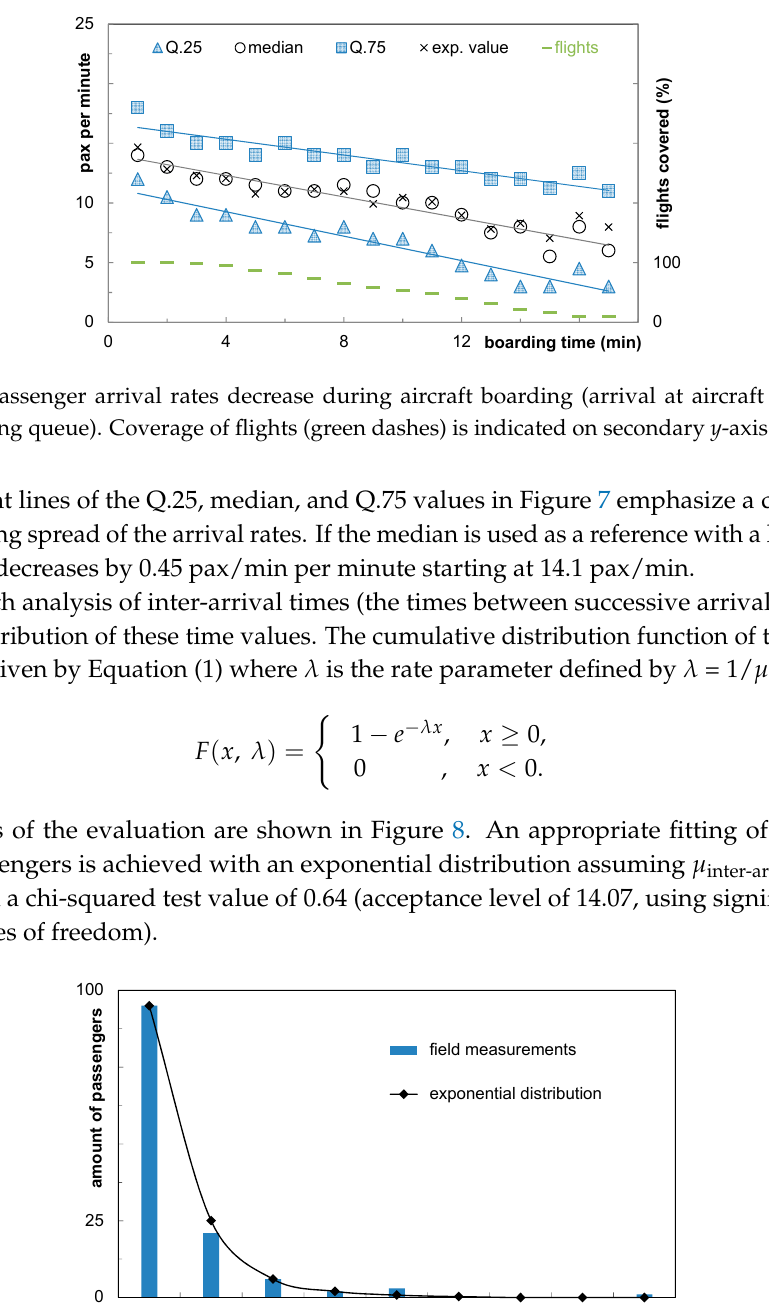
Figure 8. Inter-arrival times clustered in 5 s intervals and exponential distributed values.